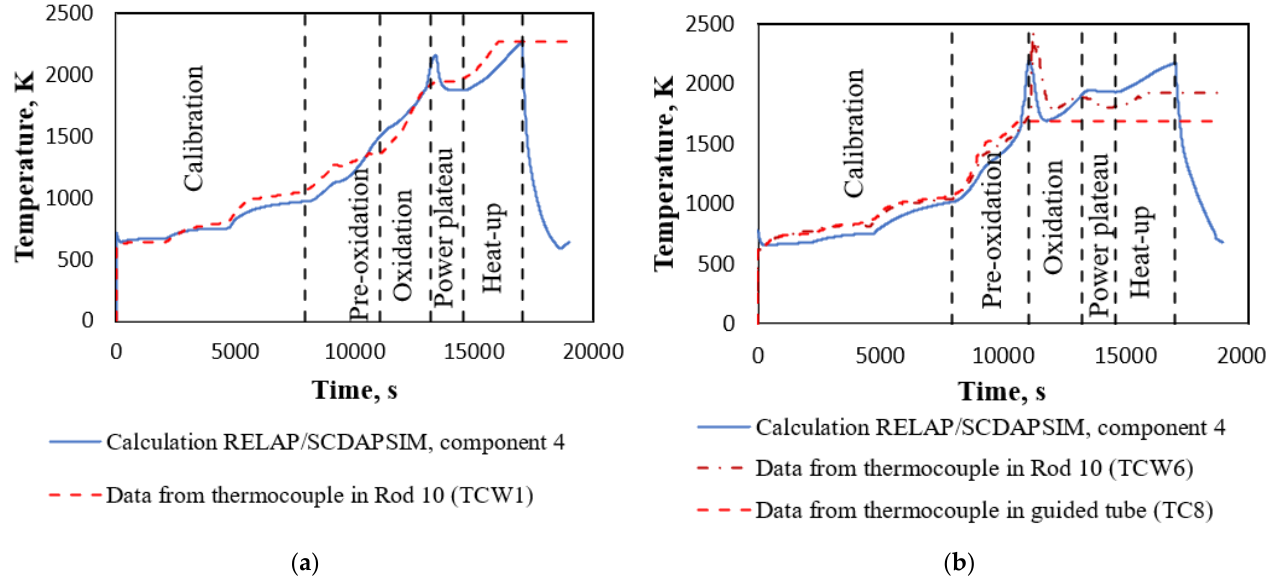
Figure 7. Comparison of the calculated temperature of fuel rod claddings with experimental data at the different elevations: ( a ) 300 mm elevation from the bottom of active fuel; ( b ) 700 mm elevation from the bottom of active fuel.